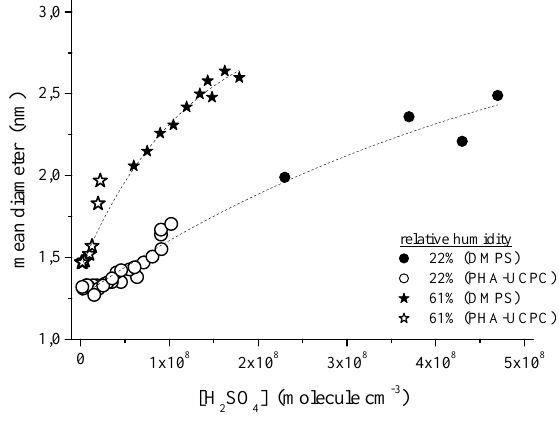
Fig. 8. Comparison of simulated nucleation rates according to Eq. (2a) for RH=22% and RH=61% with atmospheric data ob- tained in Heidelberg and Hyyti¨al¨a (Riipinen et al., 2007) as well as results of derived parameterizations from atmospheric measure- ments in Tecamac and Hyyti¨al¨a as given by Kuang et al. (2008). Period of measurements is given behind the sites, month/year.